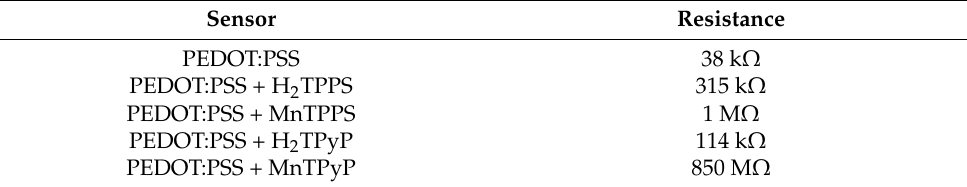
Table 1. Baseline resistance of prepared sensors. Sensor Resistance